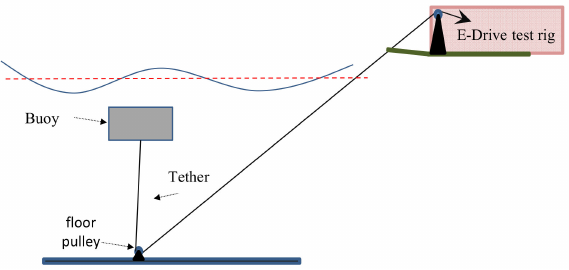
Figure 13. Schematic of the testing architecture used to demonstrate the system.